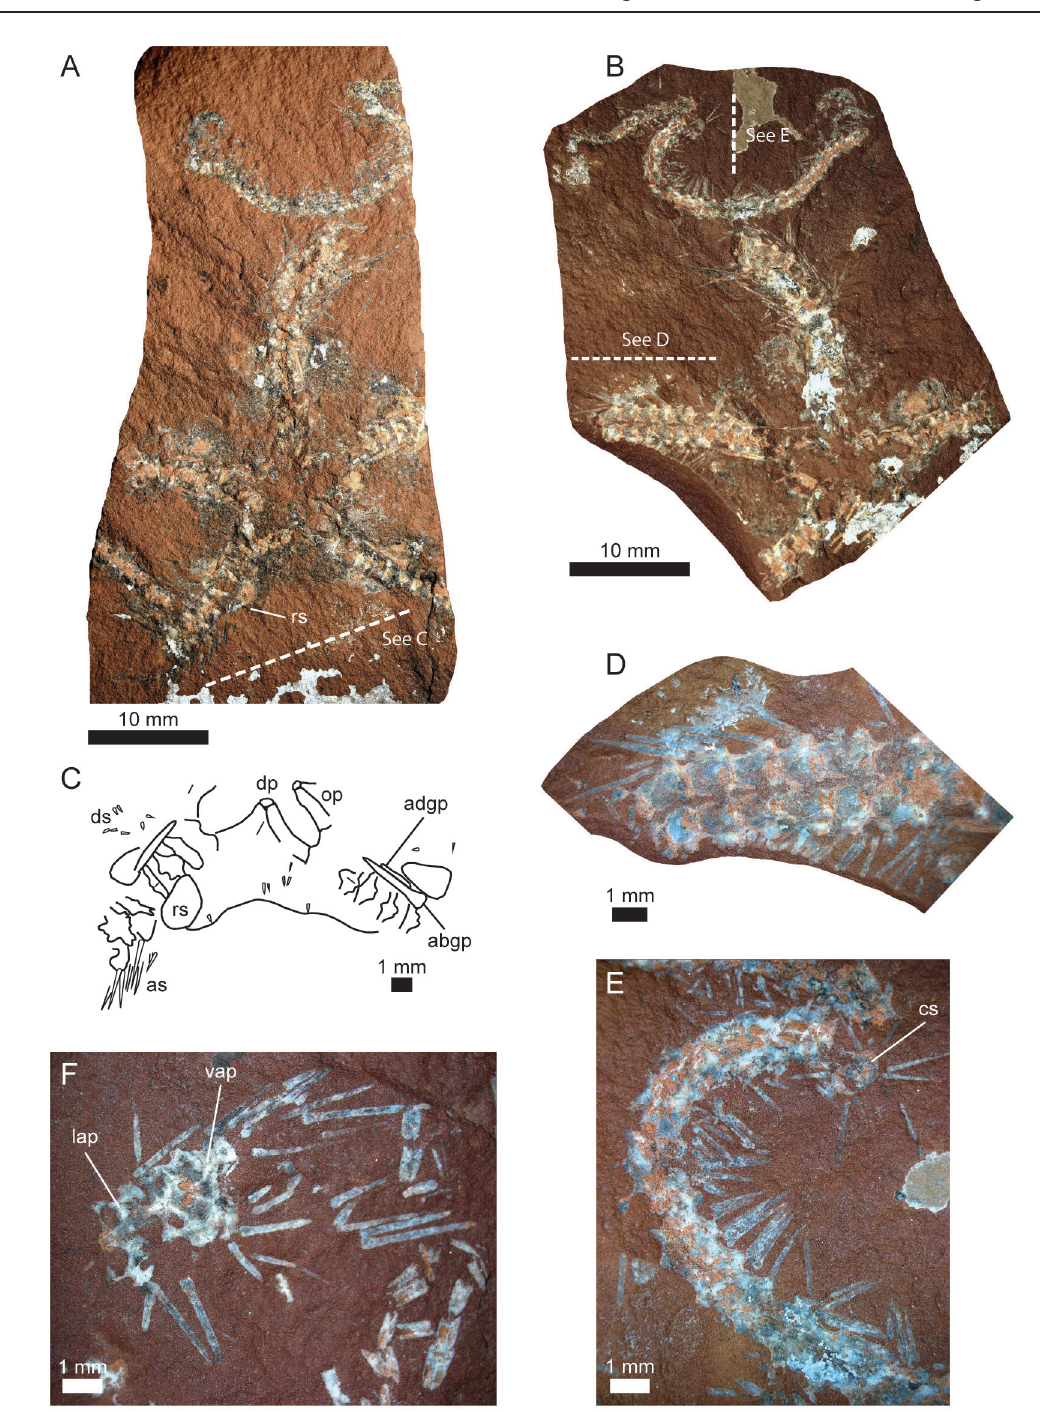
Fig. 5. Ophiogaleus sp. A–E . PMO 218.060, specimen preserving the ventral side of the disc area and the base of all five arms. The specimen has been split through a horizontal plane and is visible as part (A) and counterpart (B). Photographs in A and B by H.A. Nakrem. C . Drawing detail of the oral and interradial area. D . Detail view of proximal arm segments with articulated spines. E . Detail view of distal arm segment. F . PMO 218.053a, partly disarticulated arm portion composed of three median segments showing details of the ventral side of the arms. Abbreviations: abgp = abradial genital plate; adgp = adradial genital plate; as = arm spine; cs = arm in cross section; dp = dental plate; ds = disc spine; lap = lateral arm plate; op = oral plate; rs = radial shield; vap = ventral